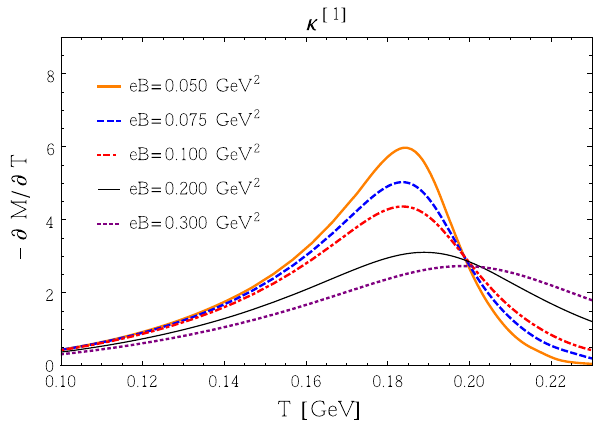
Fig. 4 − ∂ M /∂ T as function of the temperature, for different fixed values of magnetic field with fixed κ [ 1 ]